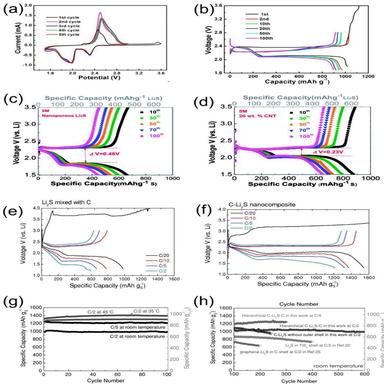
(a) Cyclic voltammograms and (b) voltage-capacity profiles of the Li2S/rGO paper electrode. Voltage-capacity profiles of (c) nanoporous-Li2S and (d) Li2S-MWCNTs cathodes . Voltage profiles of (e) Li2S/C and (f) Li2S@C electrodes . (g) Cycling performance of Li2S@HC electrodes and (h) the comparison with various types of Li2Sbased electrodes . Reproduced from Refs. with permission from the American Chemical Society, Royal Society of Chemistry